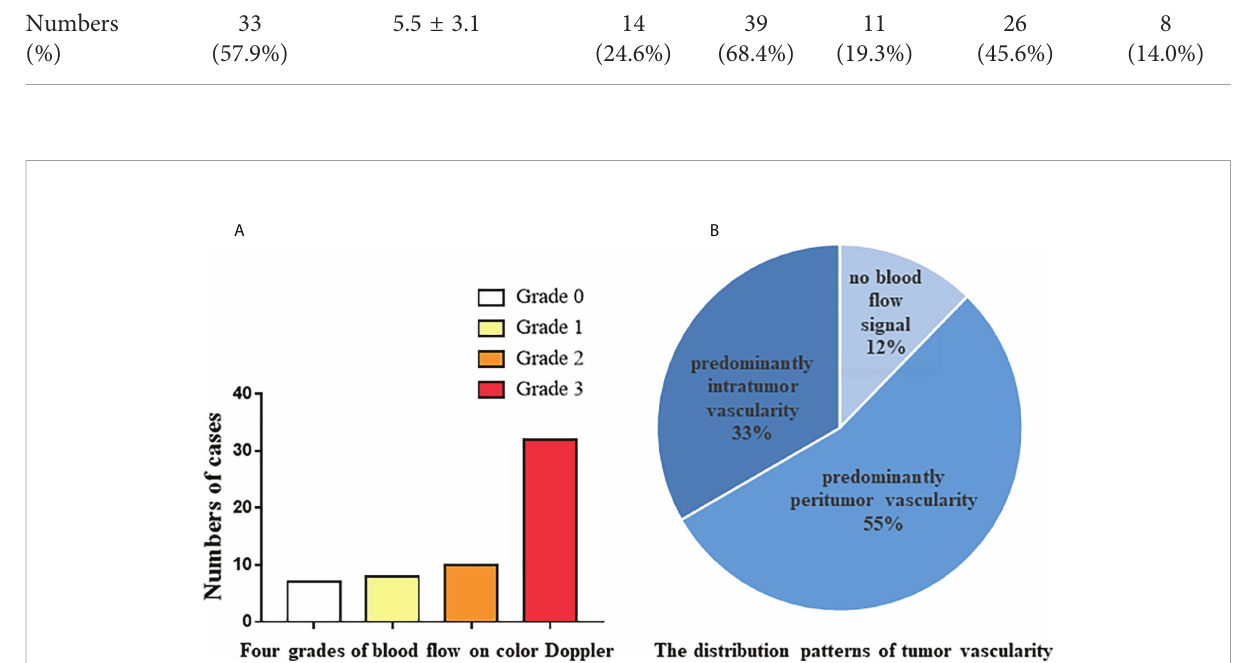
FIGURE 1 Color Doppler feutures of 57 tumor recurrence cases con fi rmed by pathology. (A) The number of cases from four grades of blood fl ow on color Doppler. (B) The distribution patterns of tumor vascularity on color